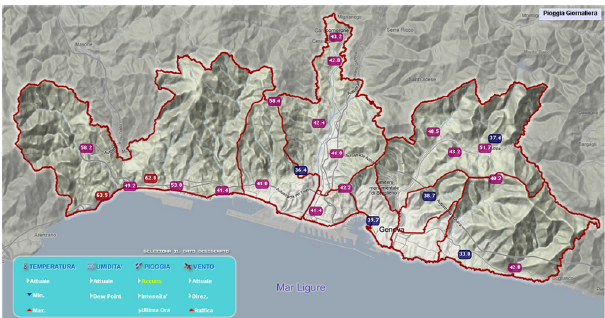
Fig. 13. Genoa Municipality web page (under construction) show- ing the weather station network of the Municipality administration: daily rainfall amounts (mm) are shown real-time in correspondence of the different rain gauges. The color of small boxes varies in re- lation to the rainfall amount. The system also provides all the other usual weather parameters in real-time (e.g.: instantaneous, min. and max. temperature, relative humidity, dewpoint, wind direction and intensity) as well as graphs and tables based on historic